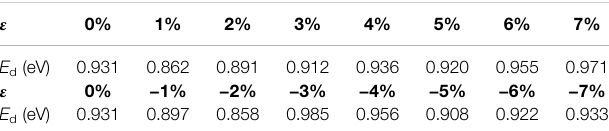
TABLE 8 | Activation energies of P b1 defect depassivations under tensile and compressive strains.